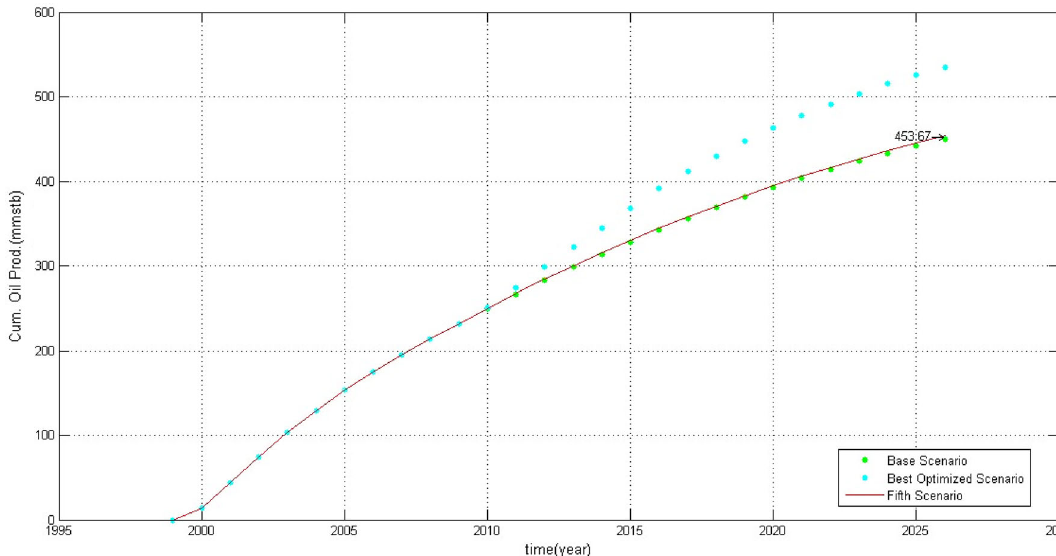
Fig. 10 Cumulative oil production of fifth scenario